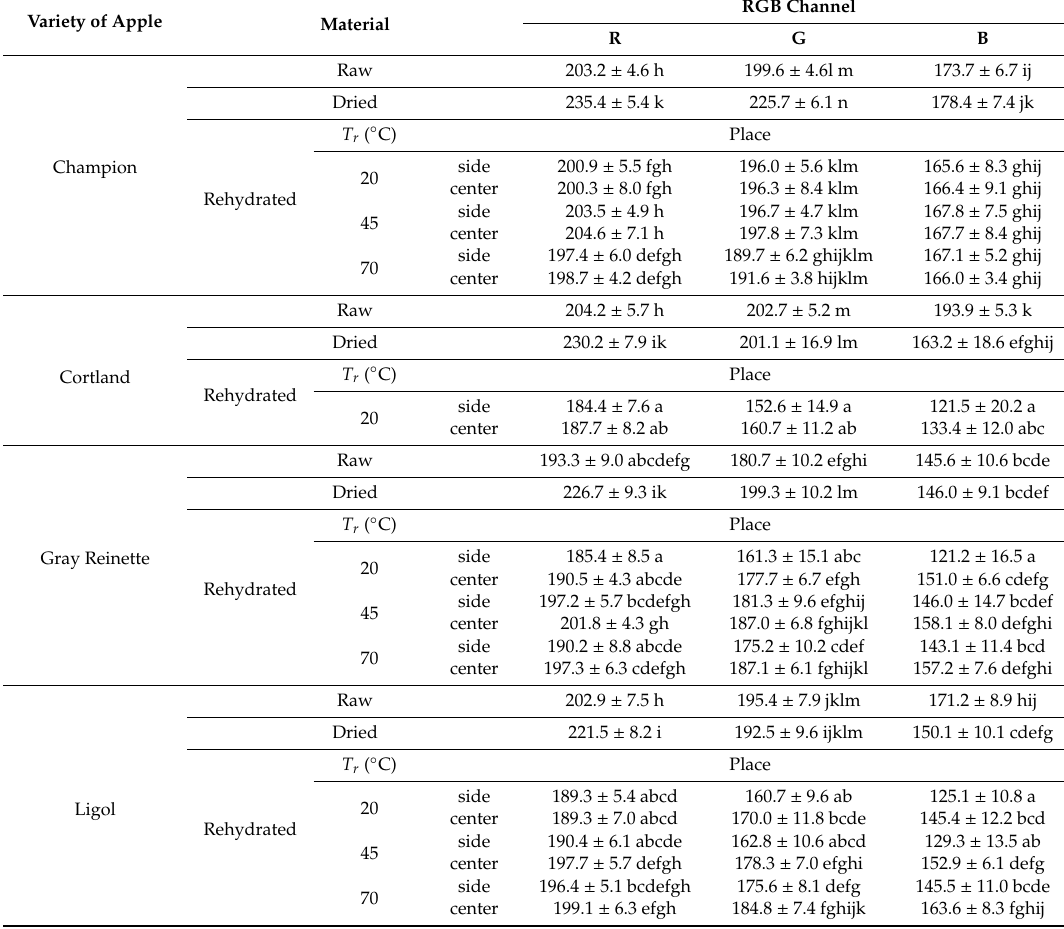
Table 8. Results of statistical analyses on the RGB color attributes of di ff erent varieties of raw, dried and dried apples during rehydration at di ff erent